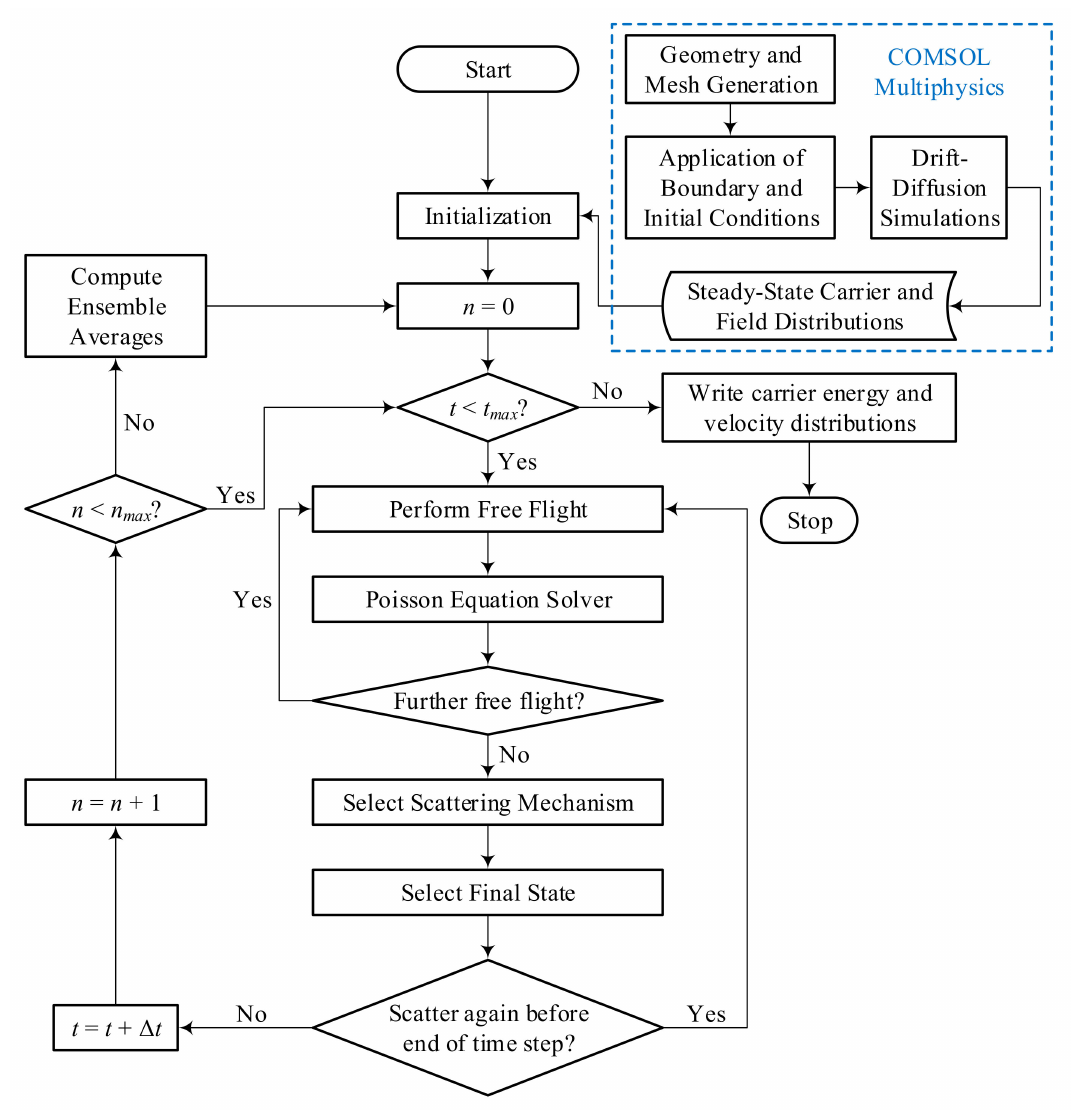
Figure 1. Flowchart of the ensemble Monte Carlo method used in this study. t max represents the total simulation time, n max represents the number of time steps that constitute a single sub-history and n represents the number of time steps that have passed since the last ensemble average